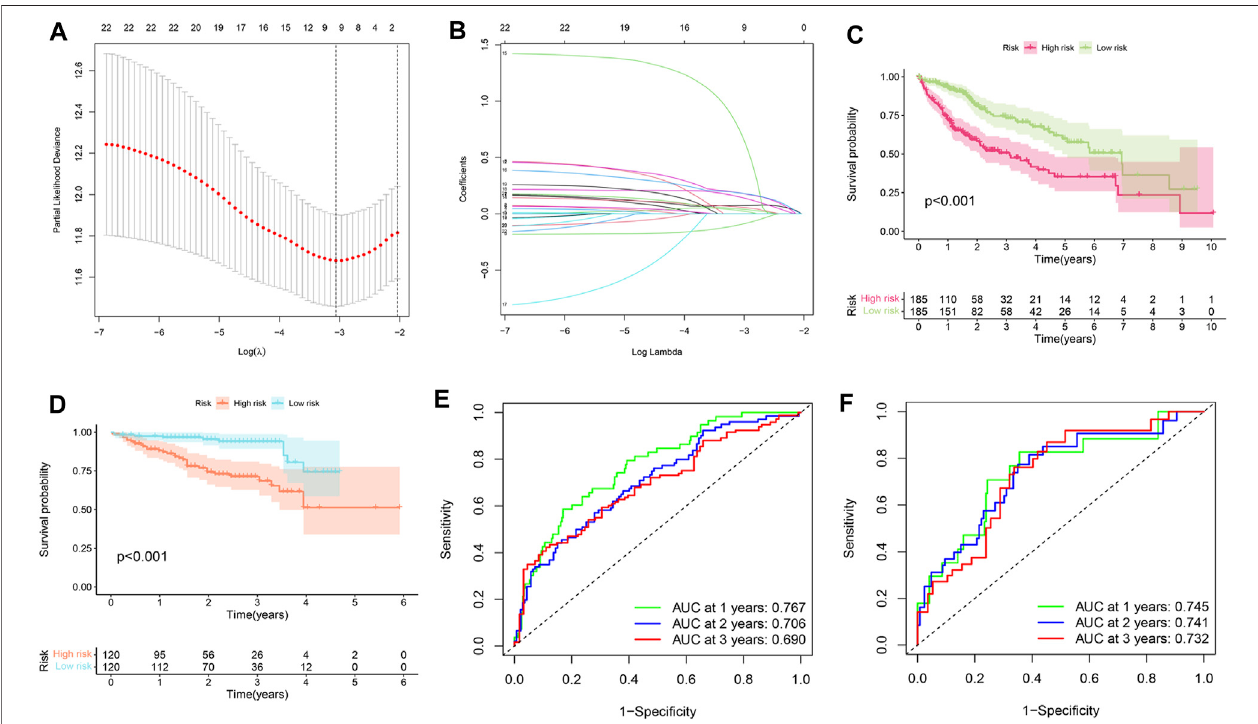
FIGURE2| ConstructionoftheSLC-relatedprognosticsignature. (A,B) LASSOregression.Themostsuitablenumberofgenesforsignatureconstructionis9. (C) Survival analysis in training set (TCGA cohort). HCC patients in the TCGA cohort can be divided into high-risk and low-risk groups based on the LASSO regression risk scoringformula.Theprognosiswassigni fi cantlyworseinthehigh-riskgroup. (D) Survivalanalysisinvalidationset(ICGCcohort).Similarly,patientsinthehigh-riskgroup were found to have worse prognoses. (E) Signature ’ s ROC curve was built in the training set to evaluate its accuracy. The area under the curve (AUC) represents accuracy. The AUC values of1, 2, and 3 years were 0.767, 0.706, and 0.690 respectively. (F) ROC curvein the validation set. The AUC values of1, 2, and 3 years were 0.745, 0.741, and 0.732